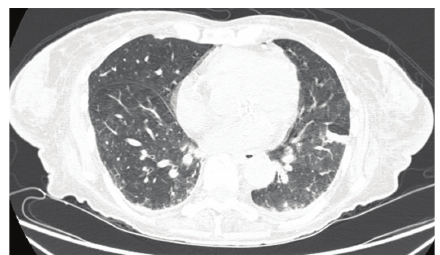
Figure 1: Computed tomography (CT) scan of the chest showed diffuse interstitial thickening and ground glass opacities.